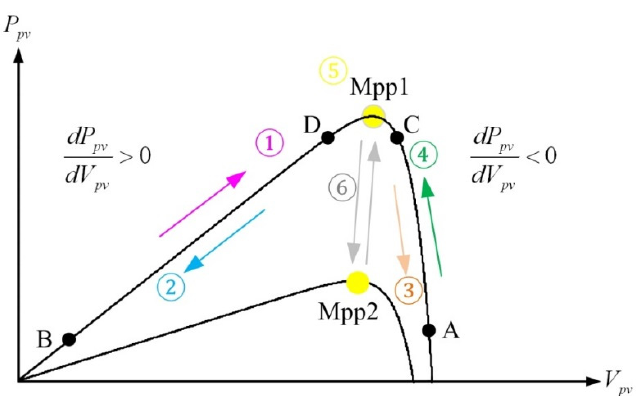
Figure 5. Typical P–V curve of a PV panel